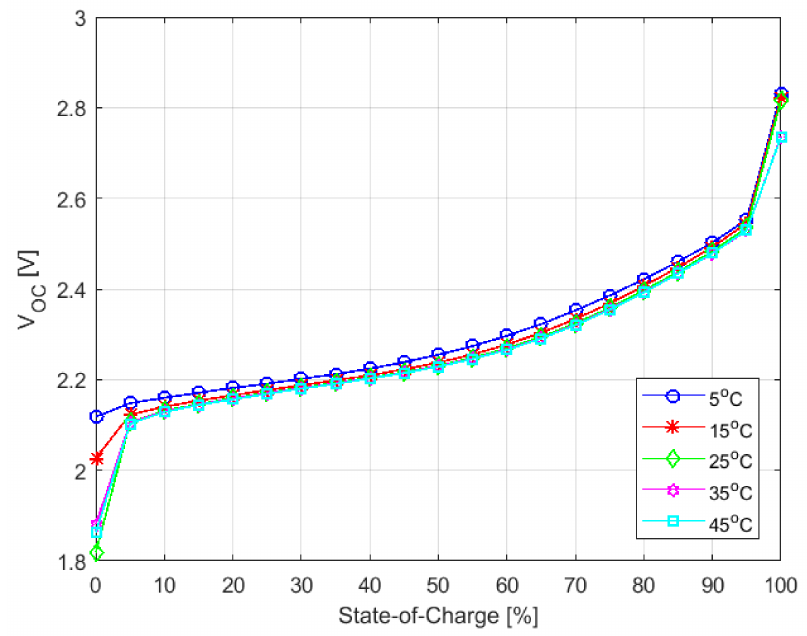
Figure 5. The OCV-SOC characteristic of the LTO-based battery measured at different